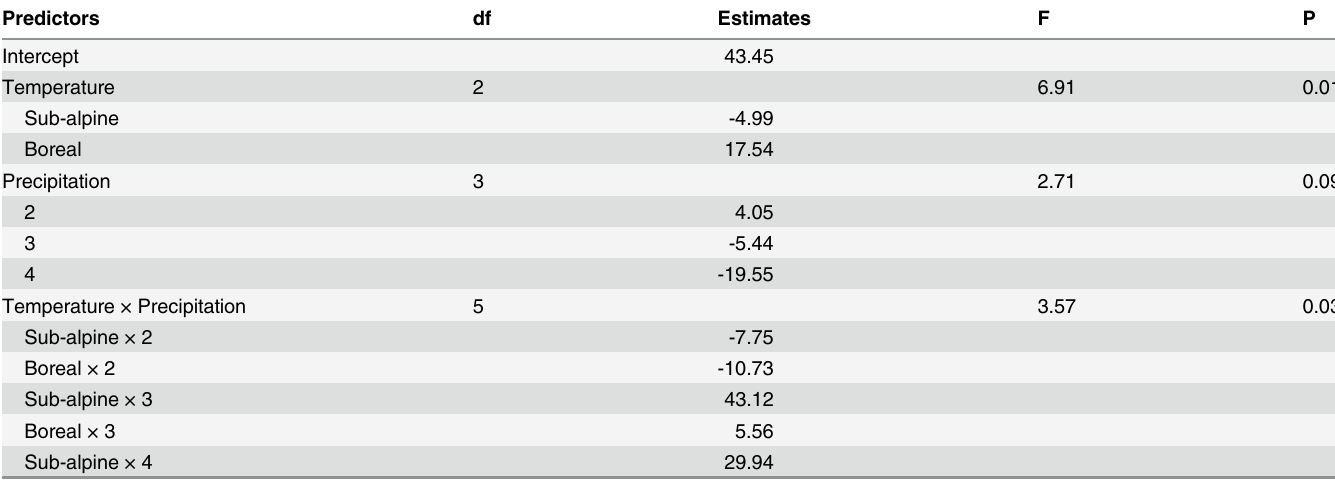
Temperature and precipitation are expressed factorial variables (three temperature levels: alpine, sub-alpine, boreal, and four precipitation levels 1 – 4). Functional type (graminoid vs forb) and its interactions were not signi fi cant and therefore not included in the fi nal model. n =